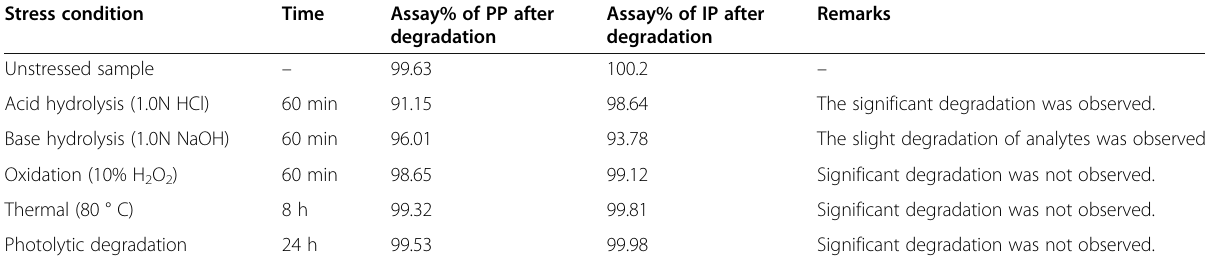
Table 1 Summary of forced degradation study results Stress condition